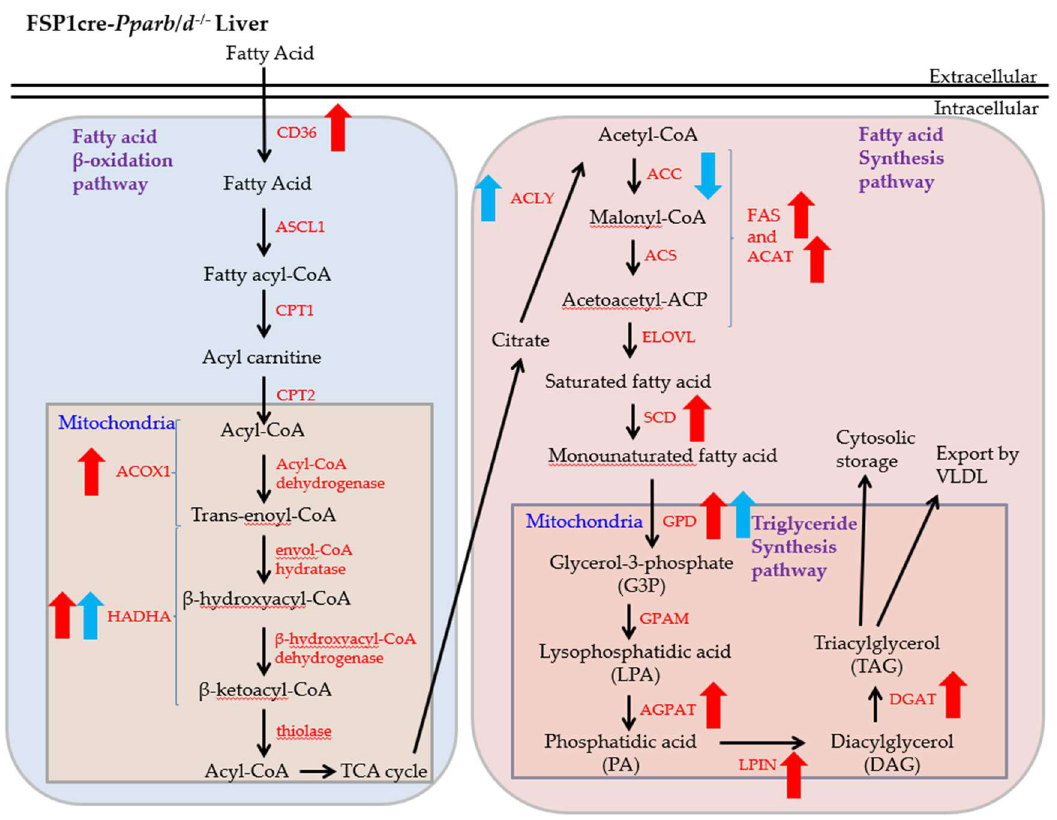
Figure 8. Overview of lipid metabolism, showing fatty acid β-oxidation, fatty acid synthesis, and triglyceride synthesis pathways affected in FSP1cre- Pparb/d −/− liver. Enzymes in the pathways are labeled in red, and RNA expression of those tested in this study and upregulated are indicated by a red arrow. Protein expression of HADHA and GPD, and ACLY and ACC activities, tested in this study are indicated by a blue arrow. For ACC, the down orientation of the blue arrow indicates a reduction of phospho-ACC in the liver of FSP1cre- Pparb/d −/− mice, which should result in a more active enzyme. Red arrow: RNA expression of the enzymes tested; blue arrow: protein expression of the enzyme tested.